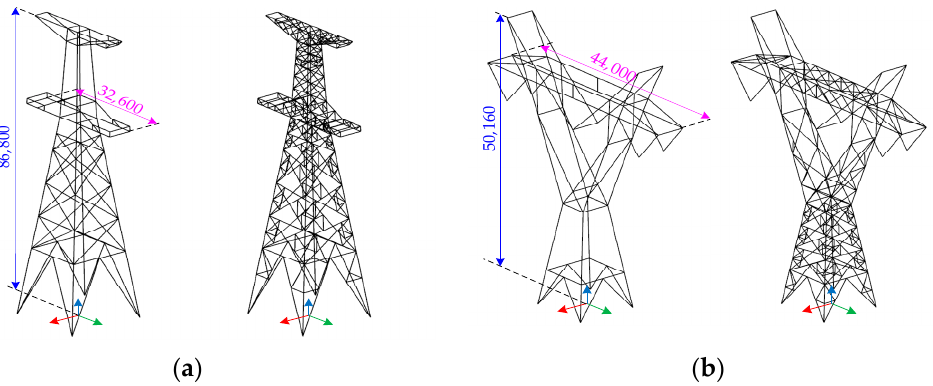
Figure 3. Line model of 1000 kV dry-type tower and 1000 kV cup-type tower. ( a ) Dry-cup tower; ( b ) Cup-type tower.